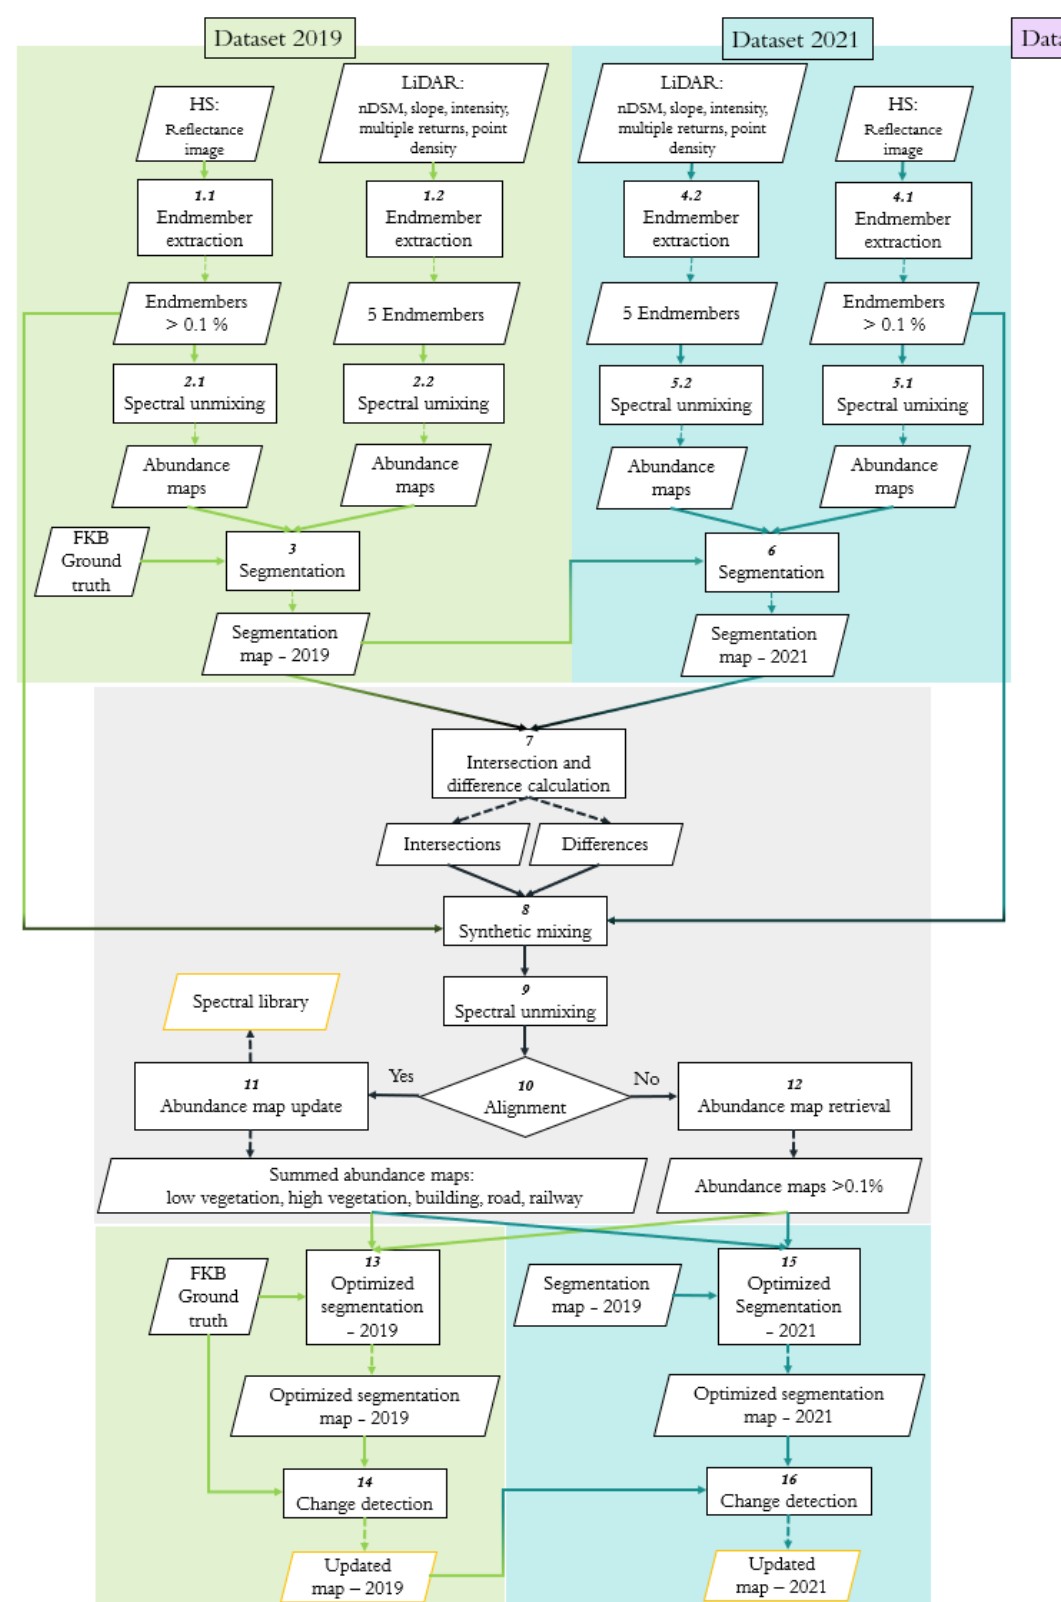
Figure 2. Schematic workflow for multitemporal HL-Fusion at the feature level. According to flowchart guidelines, parallelograms represent data input/output, rectangles—process, and rhombi—decision.